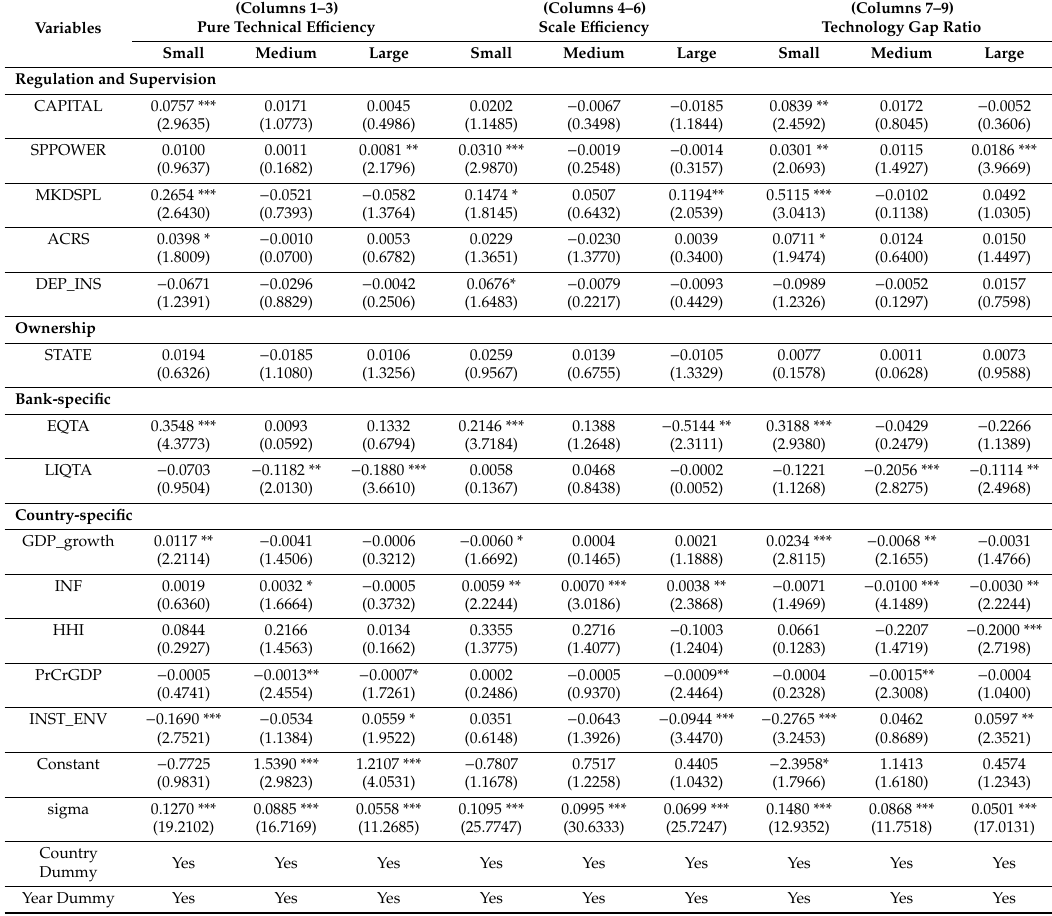
Table 9. Bootstrap truncated regression results: Di ff erent-sized bank groups.